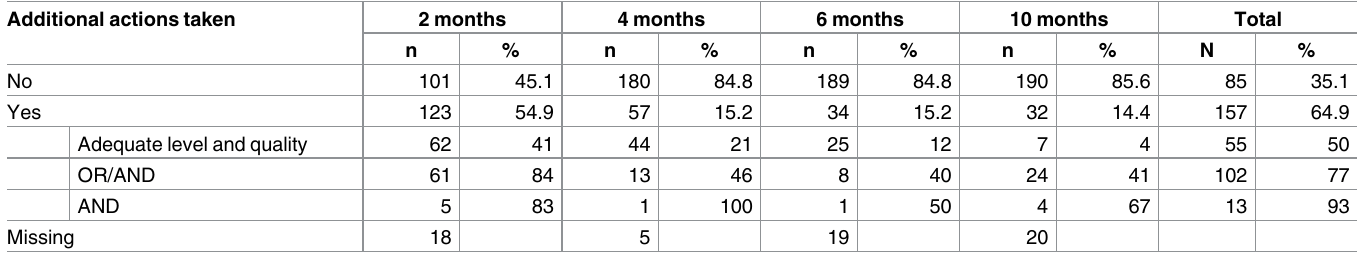
Table 4. Number and percentage of infants for whom additional actions were taken by the nurse with respectto outcome according to Structured Observation of Motor Performance in Infants. Additional actions taken